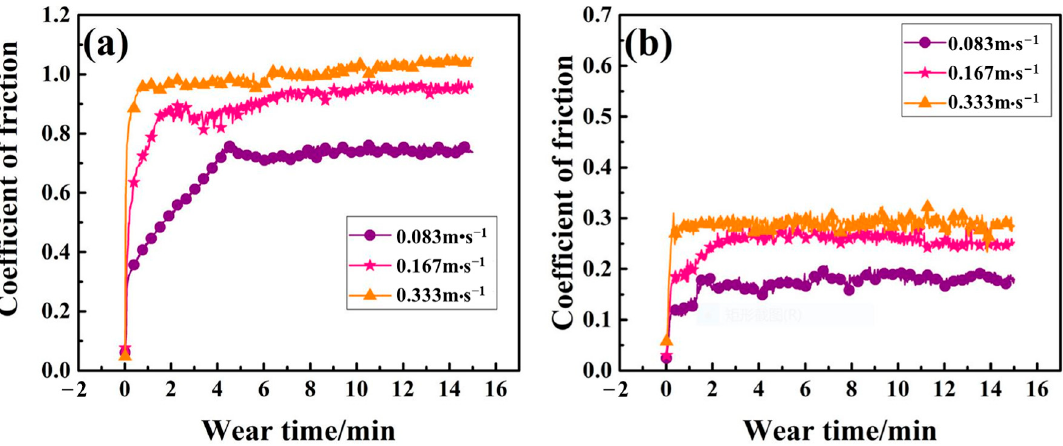
Figure 5. Friction coe ffi cients under dry-sliding against ZrO 2 ball with 0.083 m · s − 1 , 0.167 m · s − 1 and 0.333 m · s − 1 speed ( a ) substrate; ( b ) borocarburized